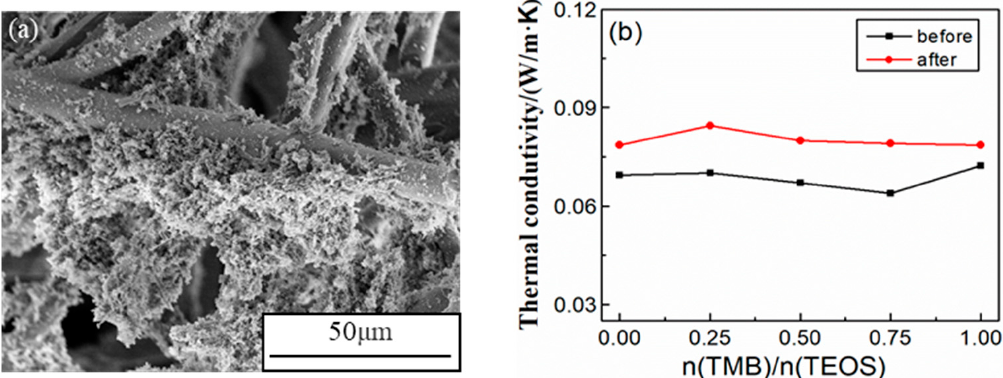
Figure 8. SEM image of the SiBCO aerogel composite ( a ) and its thermal conductivity ( b ) at room temperature before and after high-temperature treatment.